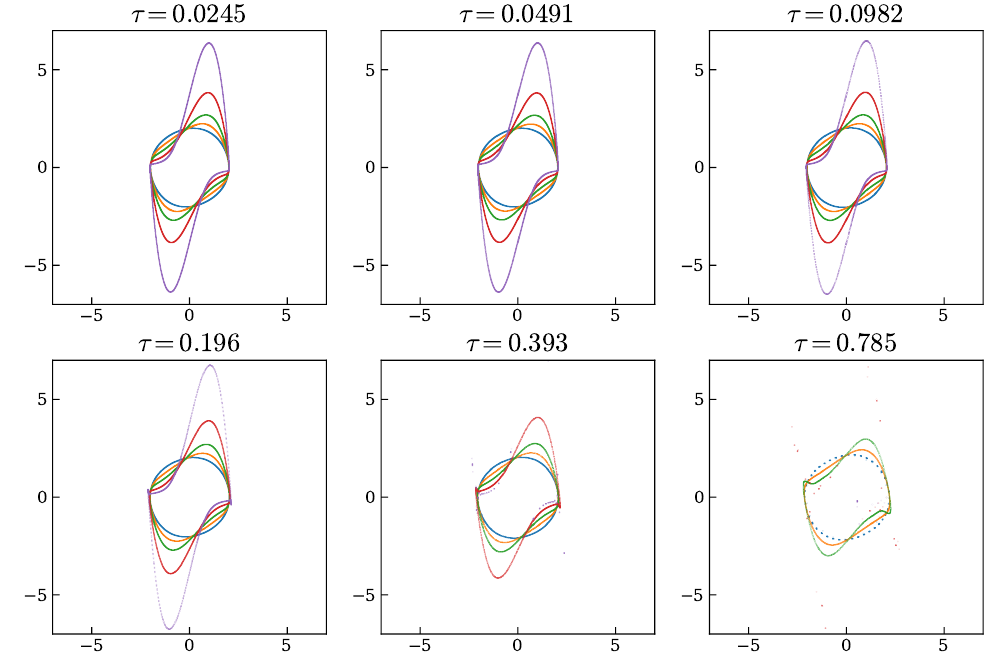
Figure 5. Limit cycle of the van der Pol oscillator computed using the variational approach of Section 3.4 for values of (cid:101) = 0.1 (blue), 0.5 (orange), 1 (green), 2 (red), 4 (purple) and with different time